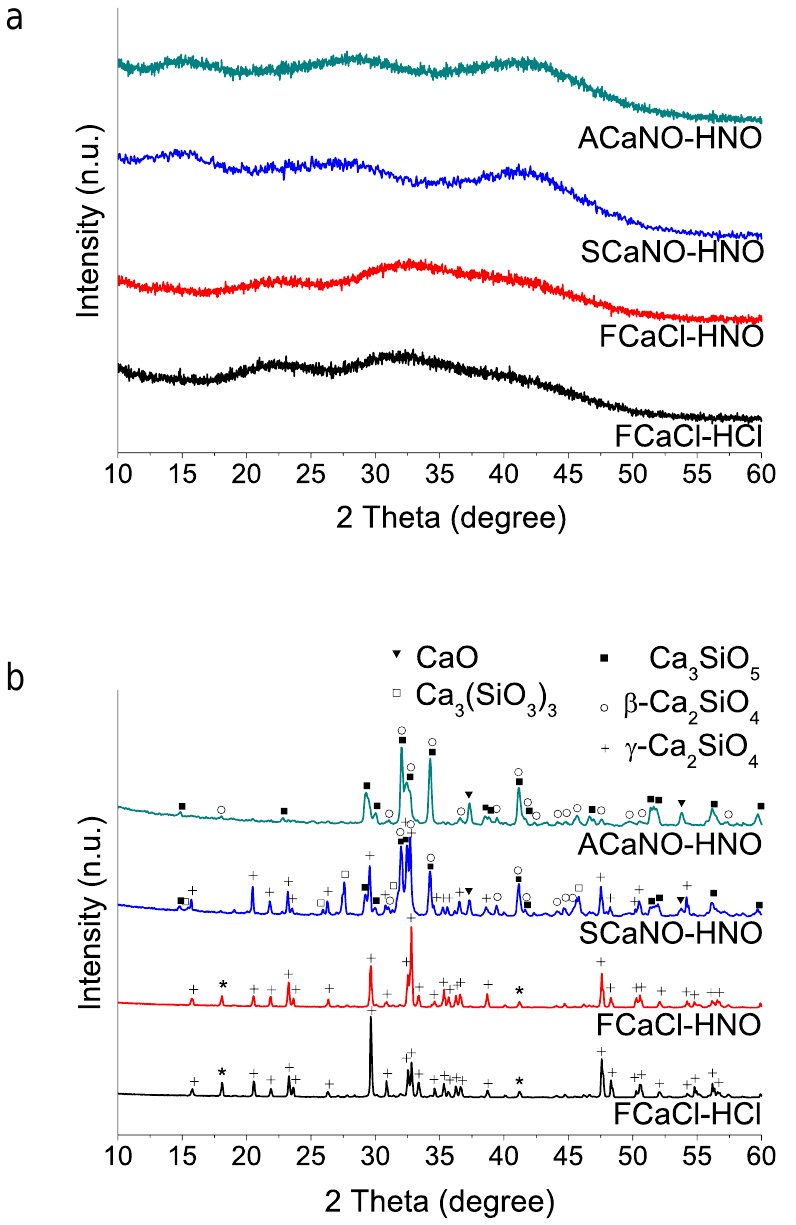
Figure 3. XRD patterns of sol – gel BEC preparations using different reactive sources as specified in Table 1: ( a ) as-synthesized powders (without heating treatment); ( b ) after heat treatment at 1400 °C. The two peaks marked with asterisks could not be matched to any phase of the database records.